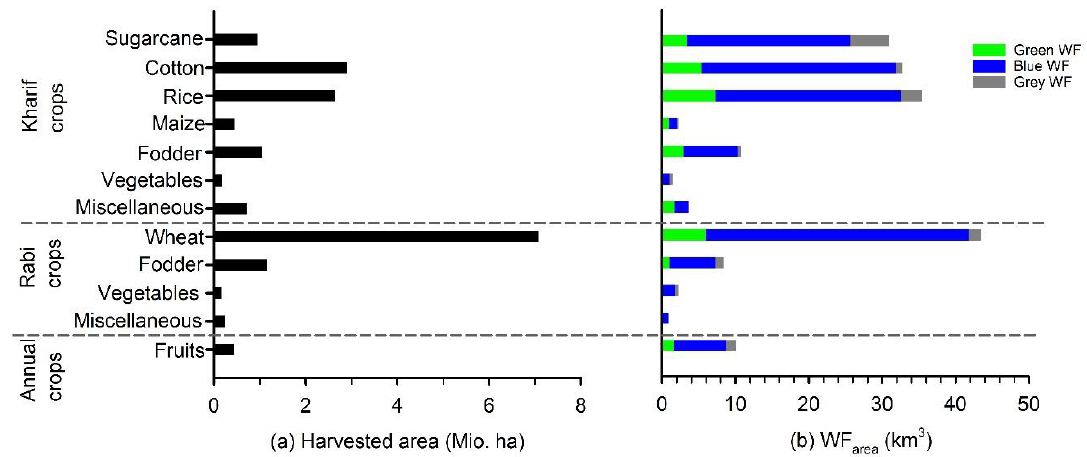
Figure 3. Average harvested area ( a ) and WF area ( b ) for the period